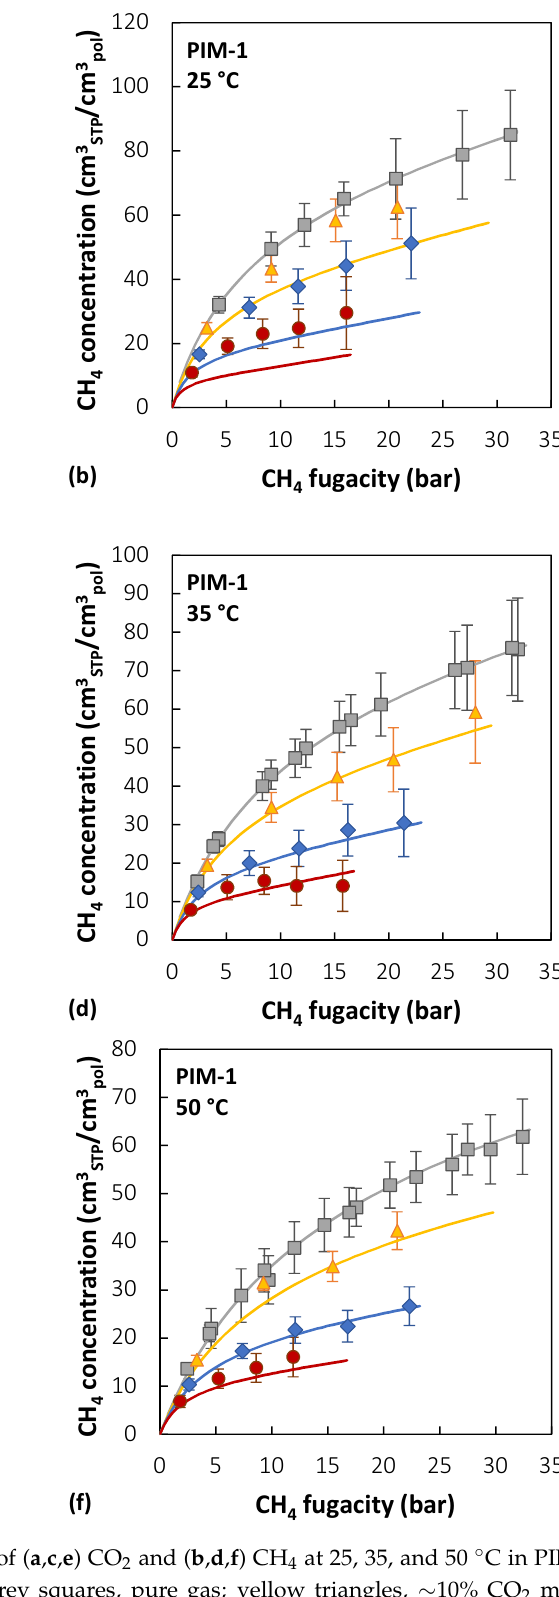
Figure 8. ( a ) Surfaces enclosing the range where DMS parameter sets yield a relative standard error 𝑅𝑆𝐸 < 𝑅𝑆𝐸 (cid:3040)(cid:3028)(cid:3051) in the prediction of CH 4 sorption in PIM-1 at three different temperatures [191]; ( b ) CH 4 sorption isotherms in PIM-1 at 25, 35, and 50 °C (experimental data from [39]) calculated with all the parameter sets enclosed by the corresponding colored regions in the plot on the left [191]. All the parameter sets that satisfied the condition 𝑅𝑆𝐸 < 𝑅𝑆𝐸 (cid:3040)(cid:3028)(cid:3051) in the pure-gas sorption representation were used to calculate mixed-gas sorption isotherms using the best-fit values for 𝑏 (cid:3004)(cid:3016) (cid:3118) . To quantify the accuracy of mixed-gas prediction ( 𝑅𝑆𝐸(cid:3364)(cid:3364)(cid:3364)(cid:3364)(cid:3364)(cid:3364) (cid:3040)(cid:3036)(cid:3051) ), the average 𝑅𝑆𝐸 of isotherms at three concentrations (10/30/50 mol.% CO 2 ) for each temperature was used, and then the lowest and the highest results were selected in order to identify the best and worst predictions, labelled, respectively, Set 1 and Set 2 . The parameter sets that correspond to these two extreme cases and their 𝑅𝑆𝐸 values are summarized in Table 3. The calculated sorption isotherms are shown in Figure 9. Allowing also for experimental error, the two pure-gas representations at each temperature are deemed equivalent, and no reason for choosing one over the other can be suggested. Therefore, in the absence of mixed-gas experimental data for validation,